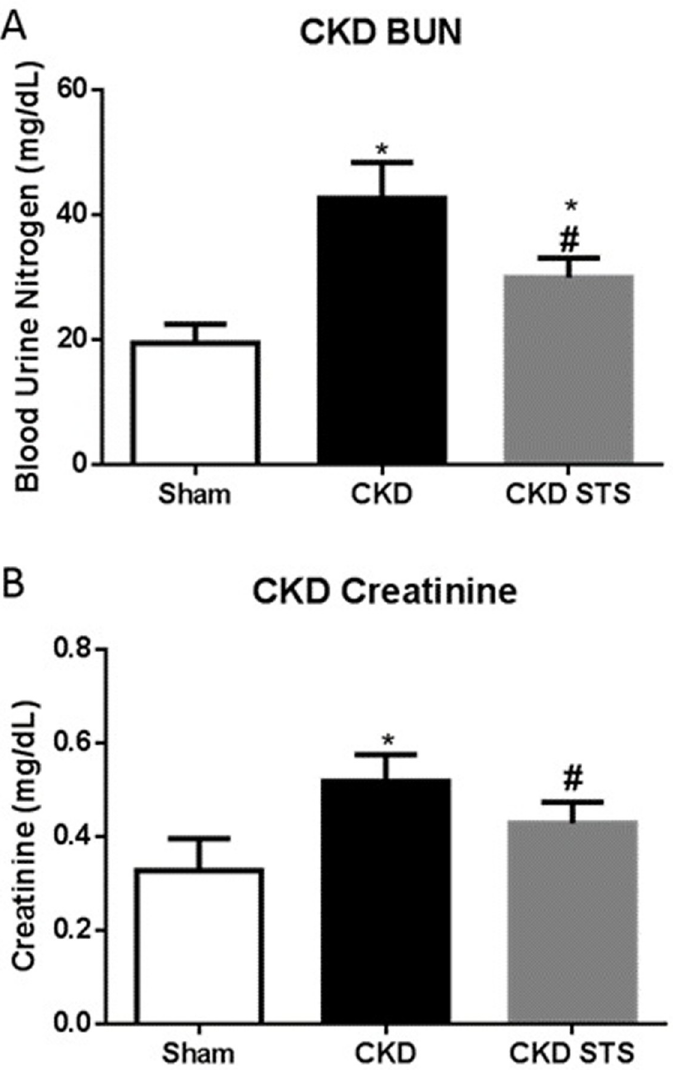
Fig 4. The STS effect on CKD induced renal dysfunction. The increased value of blood urea nitrogen (BUN, A) and creatinine (B) was denoted in the CKD rats. STS significantly depressed the increased level of BUN and creatinine in CKD STS rats as compared to CKD rats. Data are expressed as mean ± SEM (n = 6). � P < 0.05 vs. Sham. # P < 0.05 vs. CKD.